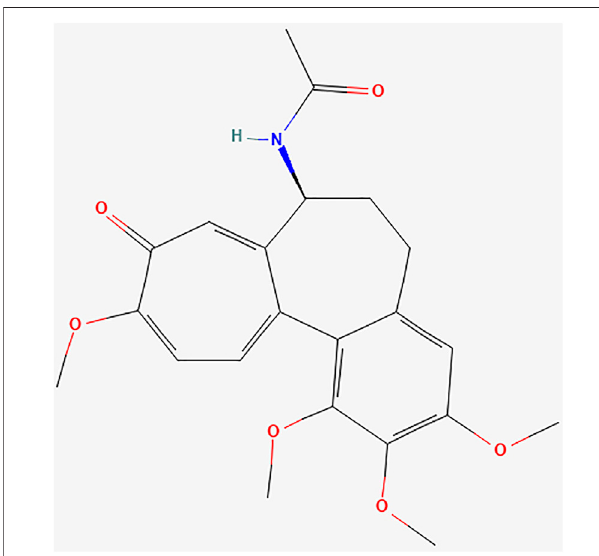
FIGURE 2 | Chemical structure of Colchicine (PubChem CID: 6167).